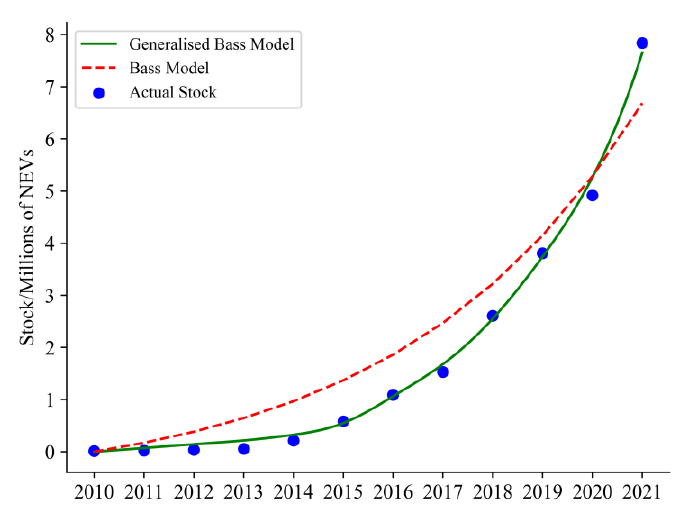
Figure 1. Comparison for Results of Improved Generalised Bass Model and Bass Model.